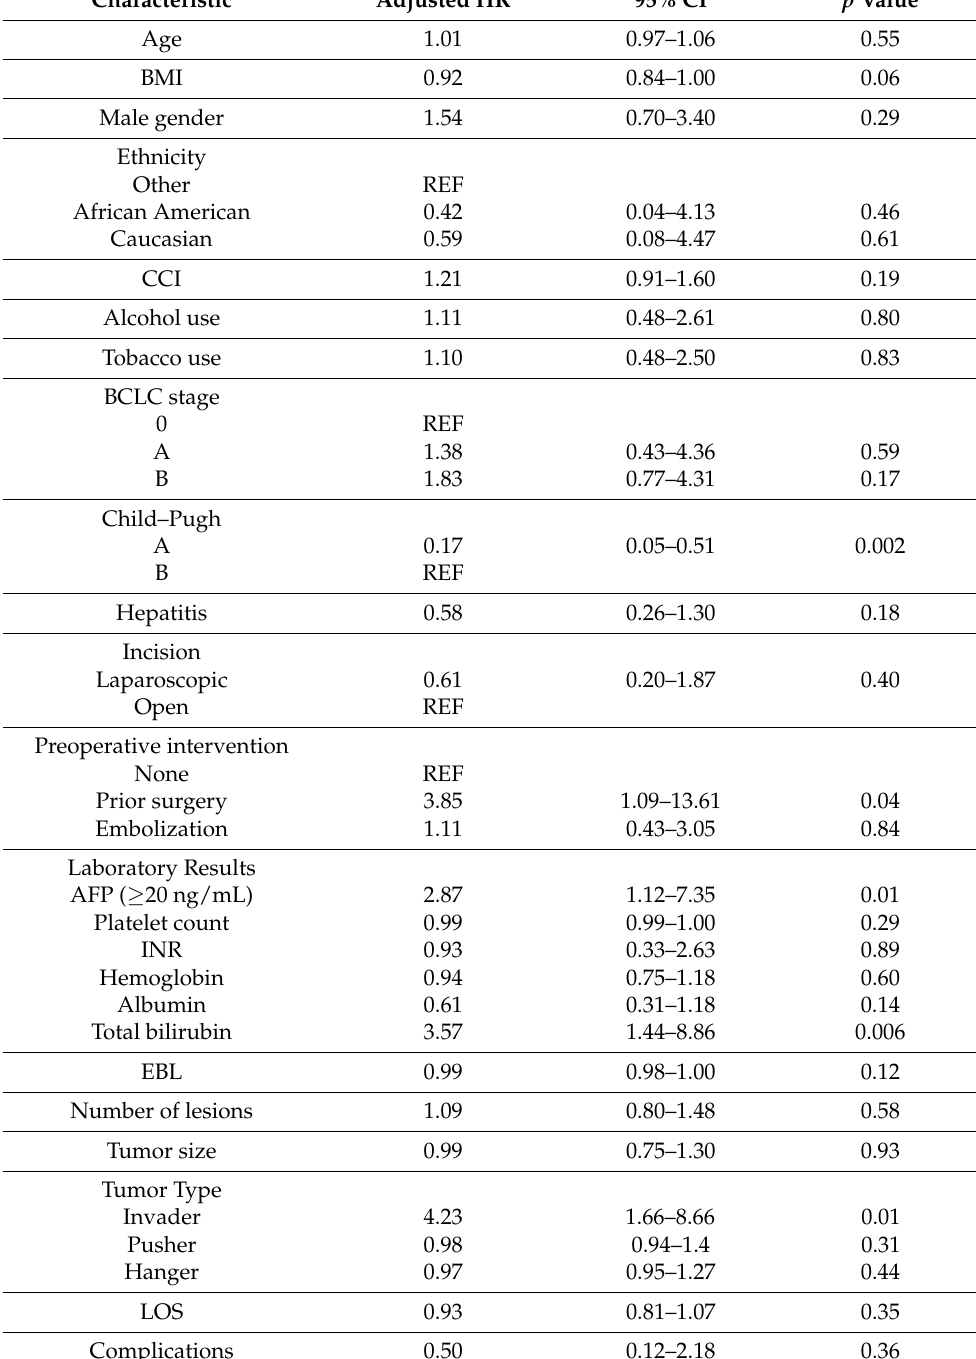
Table 4 represents univariate analysis for factors predictive of OS. Patients who were CP-A experienced prolonged OS (HR 0.17, 95% CI 0.05–0.51, p = 0.002) compared to those in class B. Next, AFP ≥ 20 ng/mL (HR 2.79, 95% CI 1.27–6.13, p = 0.01), increased total bilirubin (HR 3.57, 95% CI 1.44–8.86, p = 0.006), and operative resection prior to MWA (HR 3.85, 95% CI 1.09–13.61, p = 0.04) were negatively associated with OS. Table 4. Prognostic factors of OS univariate